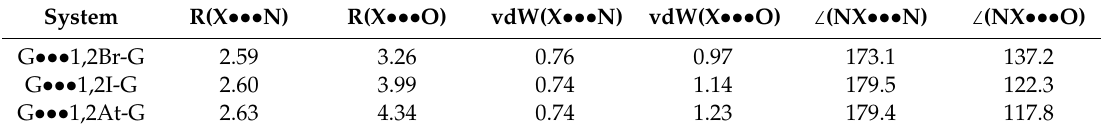
Figure 1. Optimised structures of the undoped and doped G ••• 1,2X-G (X = F, Cl, Br, I, At) base pairs starting from Hoogsteen structures, with their interaction energies (in kJ / mol). Table 2. Selected geometrical parameters (distances in Å; angles in degrees) and van der Waals